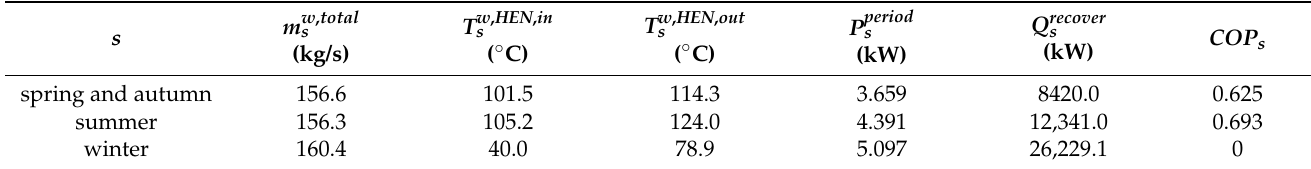
Table 8. Operation parameters of the third